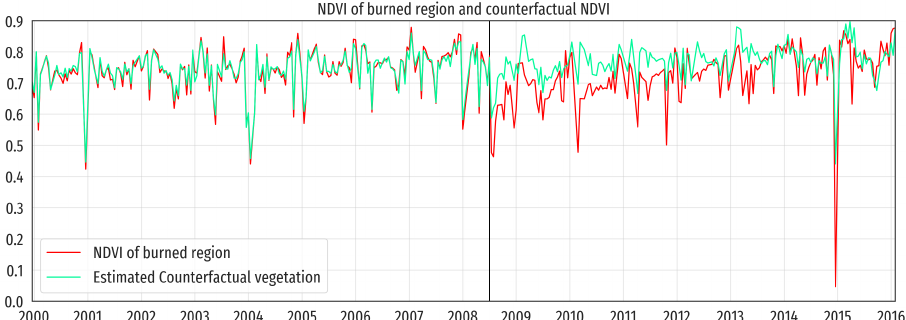
Figure 2. NDVI for MEU LIGHTNING COMPLEX (MIDDLE) wildfire. Plot of the vegetation indices NDVI of burned region and counterfactual NDVI vegetation between 2000 and 2016. This figure shows the evolution of NDVI, as well as the counterfactual estimated as explained in [18]. The data used to make this plot was obtained aggregating pixels over time of the polygons of burned areas from MTBS [24] using Google Earth Engine (GEE) [28], and the estimated counterfactual vegetation was created using the gsynth package